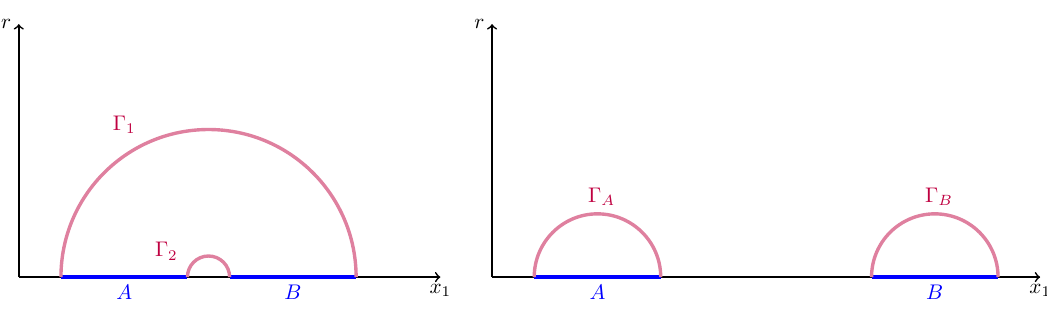
Figure 4 . An illustration of the Ryu-Takayanagi (RT) surfaces indicated in purple for the calcu- lation of HEE when the entangling region is composed of two disjoint intervals A and B along the spacial direction x . Here r is the radial coordinate in the dual gravity. ( Left ) Connected configu- 1 ration: each RT surface starts from an endpoint of one of the intervals and ends on an endpoint of another interval. ( Right ) Disconnected configuration: each RT surface starts from one endpoint of an interval and ends on another endpoint of the same interval. It should be emphasized that the RT surfaces are not necessarily half circles and this diagram is